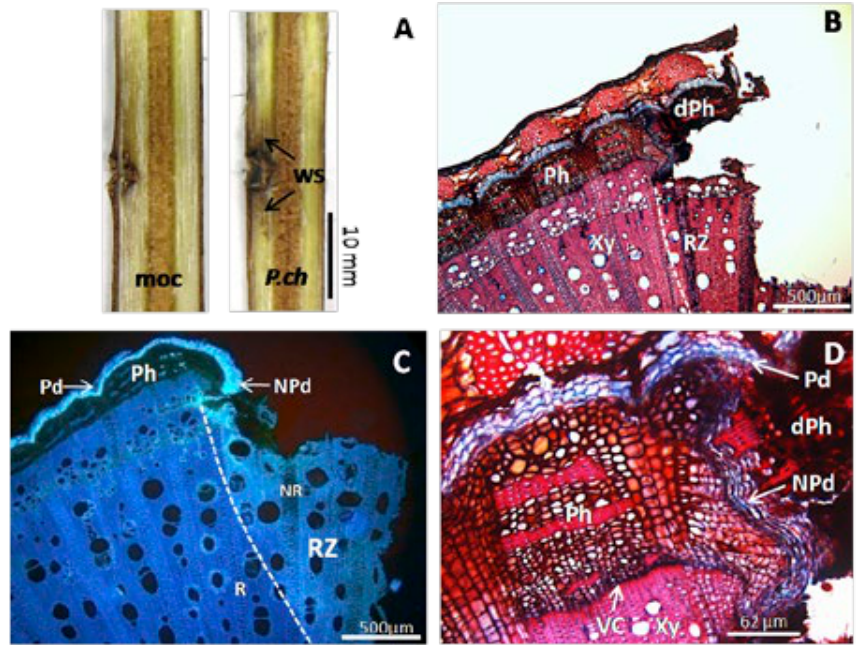
Figure 2. Effect of Pch on Vitis vinifera cv. Cabernet Sauvignon response to wounding. (A) Photographs of macroscopic phenotype observed in moc (control) and Pch -inoculated plants. WS indicates wood streaking in xylem on each side of the wound. (B, C) Large-field micrographs of (B) injured tissue stained with SfrO-AB and (C) Phl-HCl observed under UV illumination. (D) Closer view of bark structure at the border of the wound. The notation dPh stands for dead phloem, NR is for necrotic ray, NPd is for necrophylactic periderm, Pd is for periderm, Ph is for phloem, RZ is for reaction zone, V is for vessels, and Xy is for